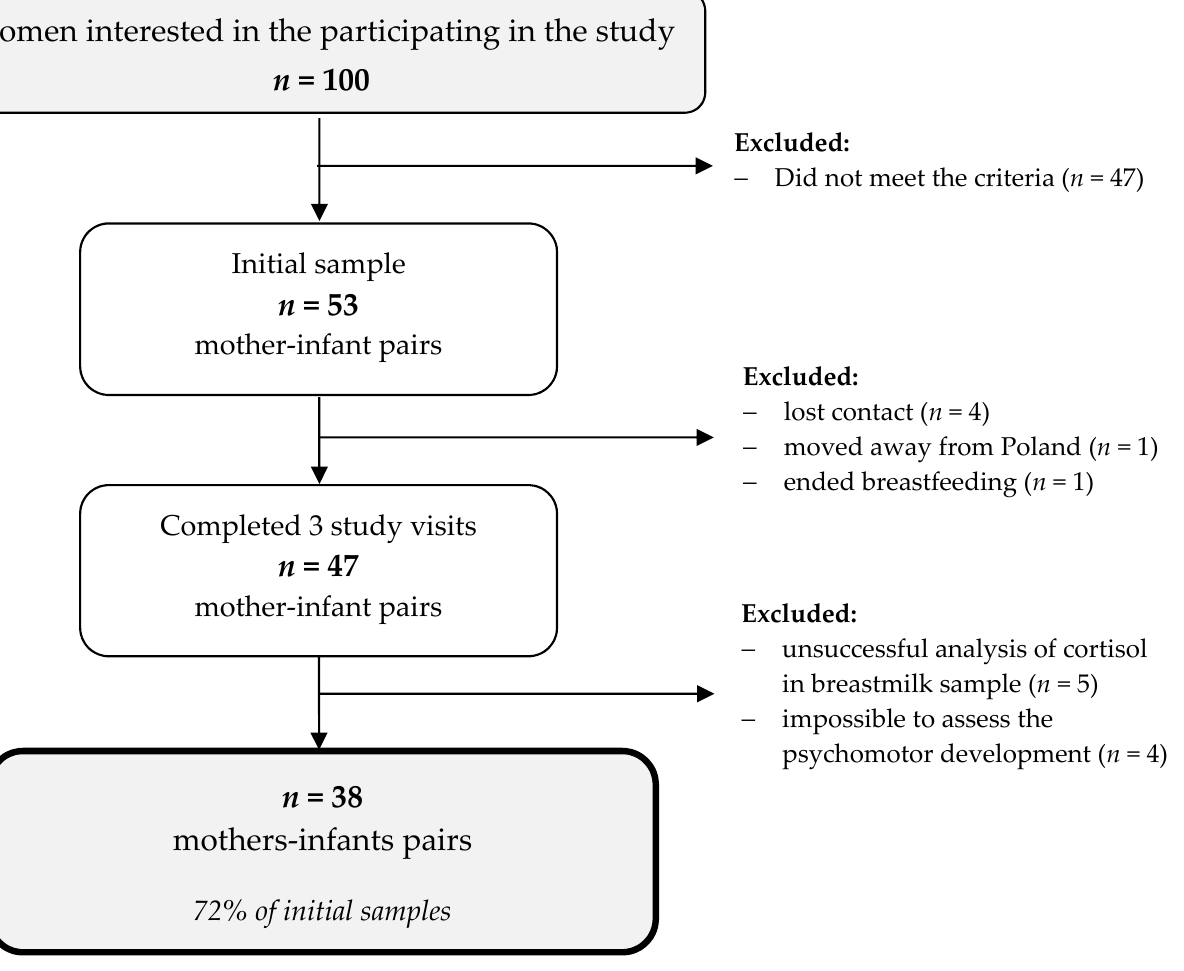
Figure 1. A flowchart of the study sample collection. Mothers included in this analysis were well educated, mostly married, and in a good economic situation, with normal BMI (Table 1). Half of them had given birth to one healthy, male infant with normal development during the first six months of